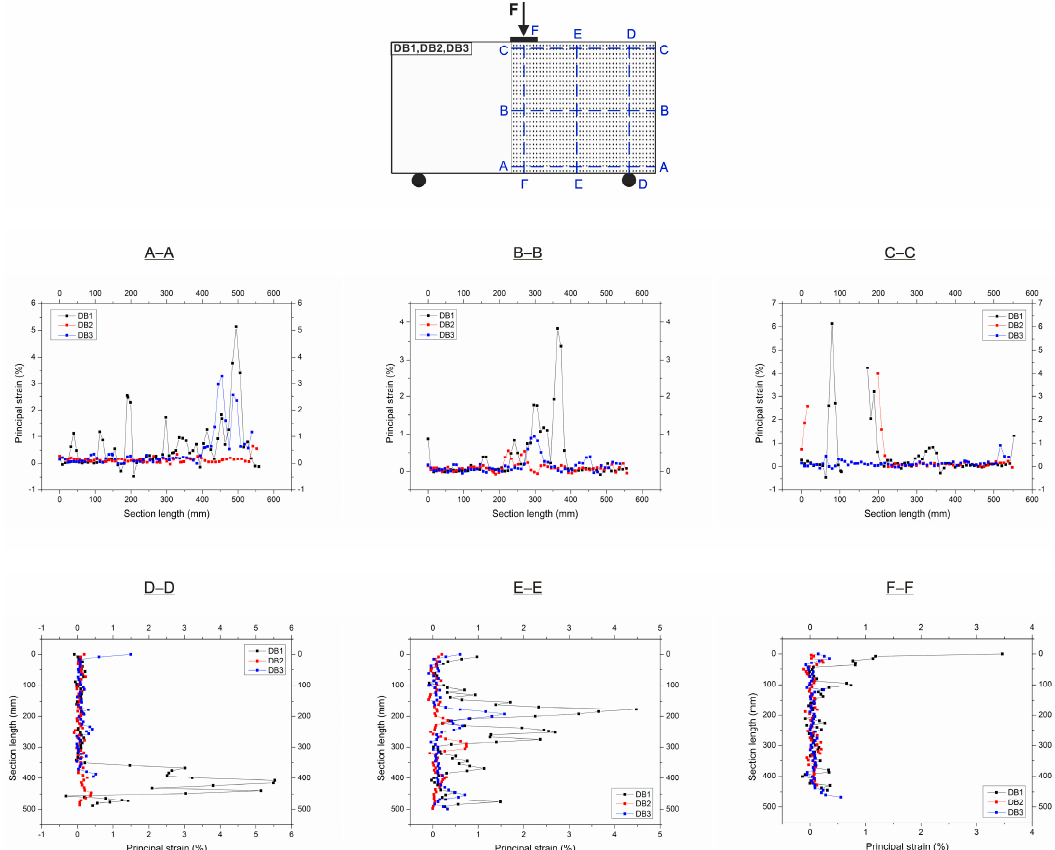
Figure 16. Principal strains of RC and fibre-reinforced concrete (FRC) deep beams at peak load.